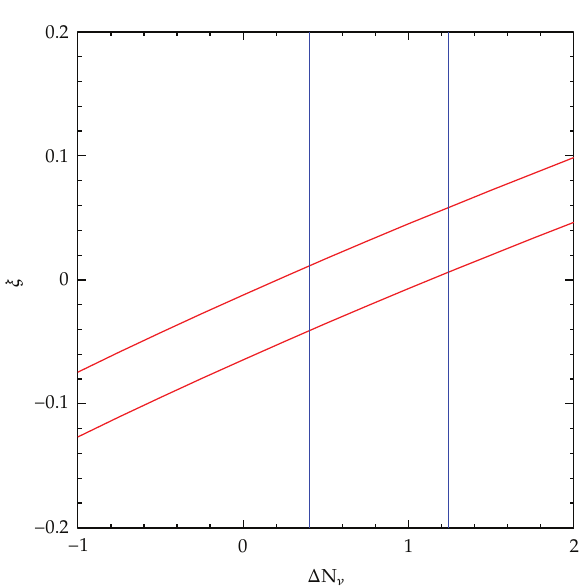
Figure 10: The ± 1 σ band (cid:3) red (cid:4) in the ξ - Δ N ν plane from BBN using the D and 4 He constraints. The blue band is the ± 1 σ range for Δ N ν from Joudaki (cid:5) 57 (cid:6) .